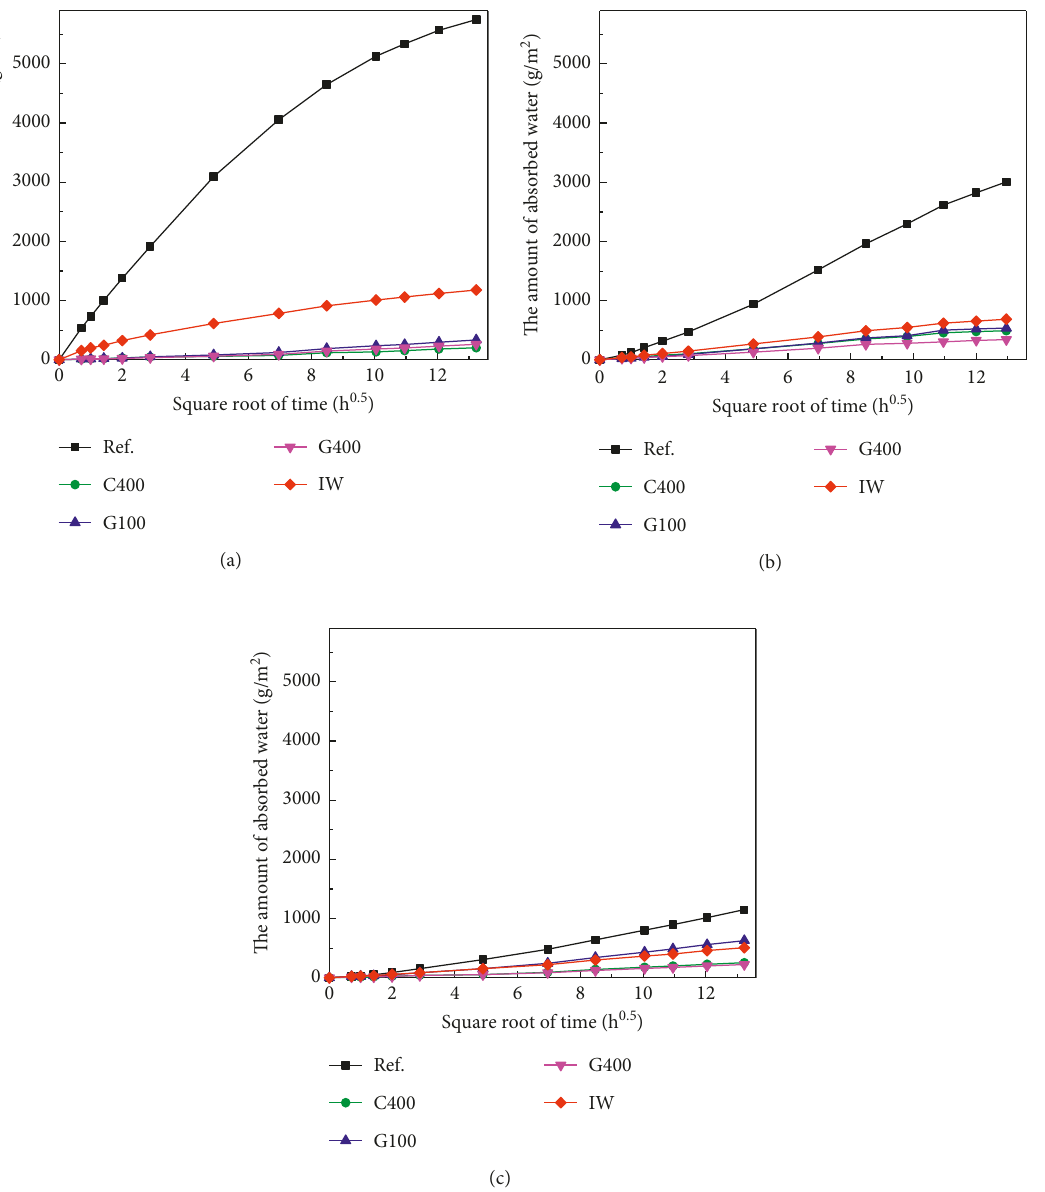
Figure 6: Water capillary absorption of water repellent-treated and -untreated concrete before and after 7 and 28 days of carbonation. (a) No carbonation. (b) 7 days of carbonation. (c) 28 days of